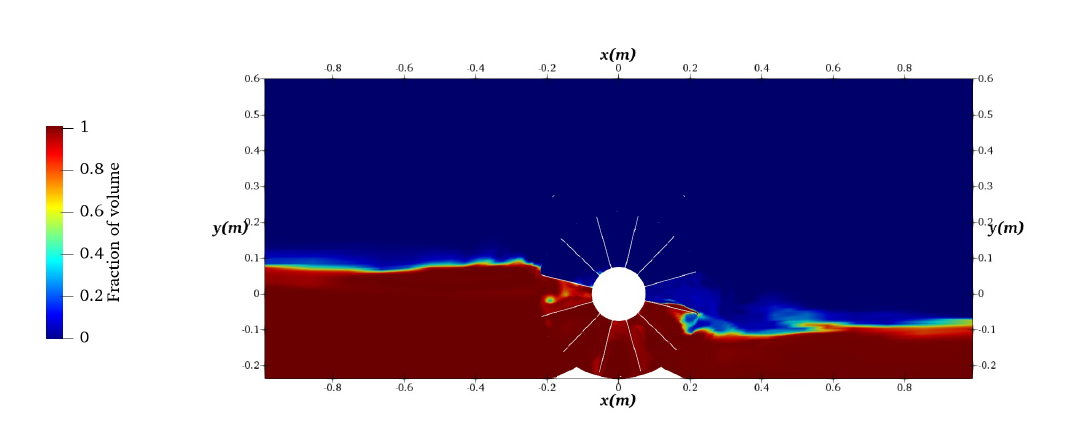
Figure 15. Slice view at the midsection of the channel of fraction of volume, at t = 4.0